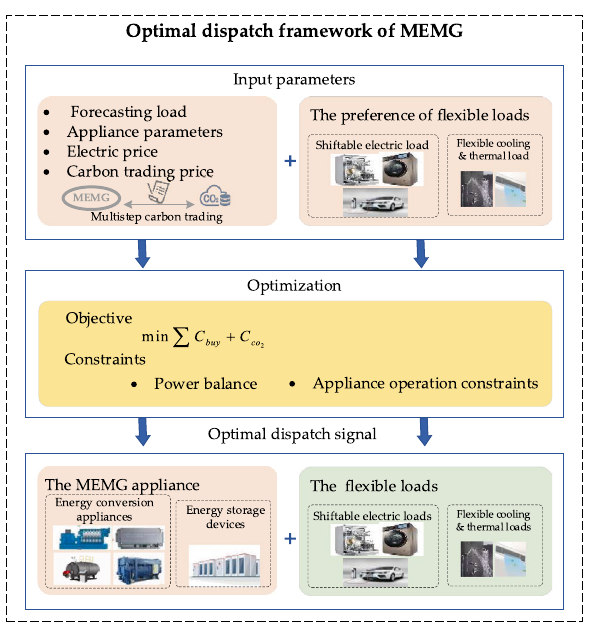
Figure 3. The proposed optimal dispatch framework of